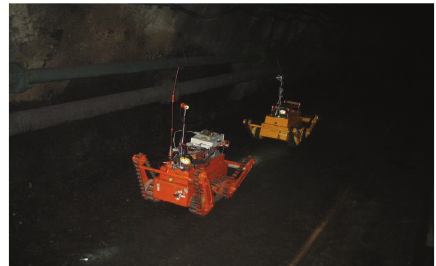
Figure 3: Coal mine rescue robot and the related sensor location map. 1, the displacement sensor; 2, power supply and drive unit; 3, the control unit; 4, multiparameter detector; and 5, the wind speed and direction sensors.